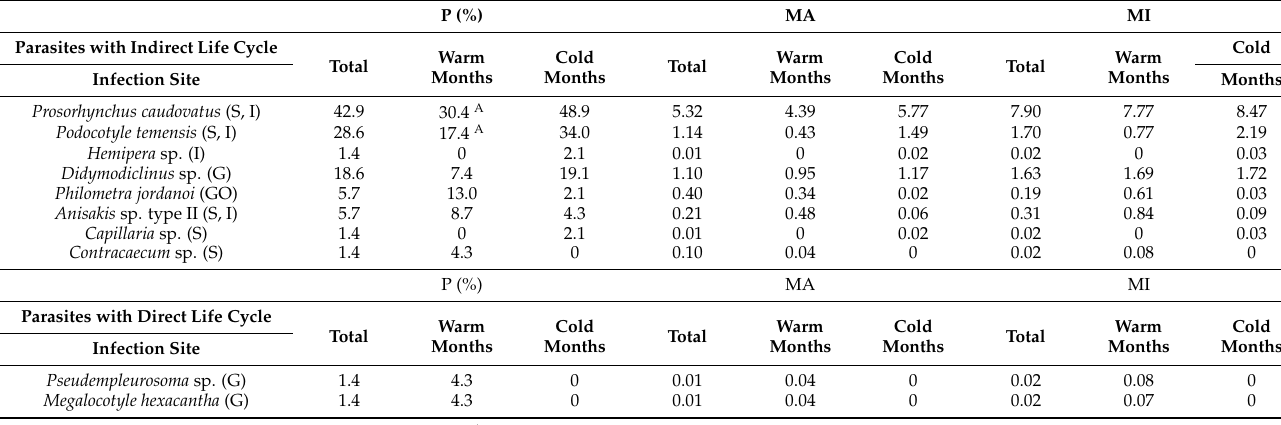
Table 1. Prevalence (P, %), Mean abundance (MA) and mean intensity (MI) and infection site (Stomach = S, Intestine = I, Gills = G, Gonads = GO) of infection of parasite species retrieved in dusky grouper specimens. P (%) MA